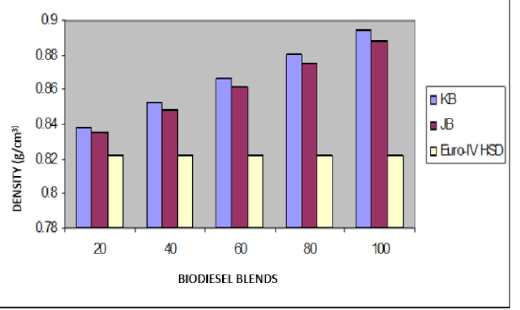
Figure 5. Variation of density of Jatropha curcus and Pongamia pinnata methyl esters blends with EURO-IV